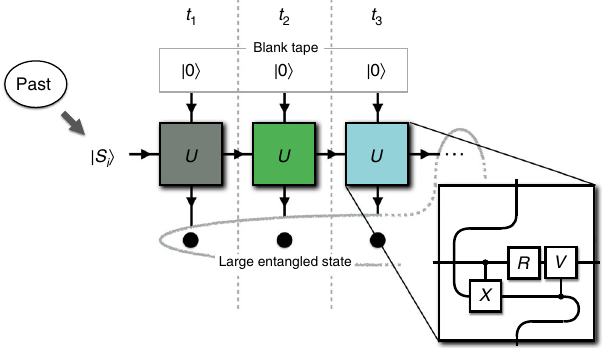
Fig. 2 Conceptual representation of the multiple-step quantum simulation of a perturbed coin. The memory system of the simulator is initialised in a qubit state | S i 〉 , where i ∈ {0, 1} depends on the past of the process. The ancillary qubits are all initialised in a fi xed known state |0 〉 — the logical zero state — and thus contain no information about the past of the process. At each time step t k , the simulator interacts with the k th ancilla through the same unitary operator U . The inset shows how we implement the relevant unitary operator. The gates are a controlled- X , a single-qubit rotation R such that R |0 〉 = | S 〉 , and a controlled- V such that VR |1 〉 = | S 〉 . This 0 1 sequence of interactions results in an entangled internal state that includes all the ancillary qubits and the memory state of the simulator. Measuring the ancillas samples the statistical distribution of the process, and at the same time the internal state of the simulator collapses into the correct memory state required for further simulation